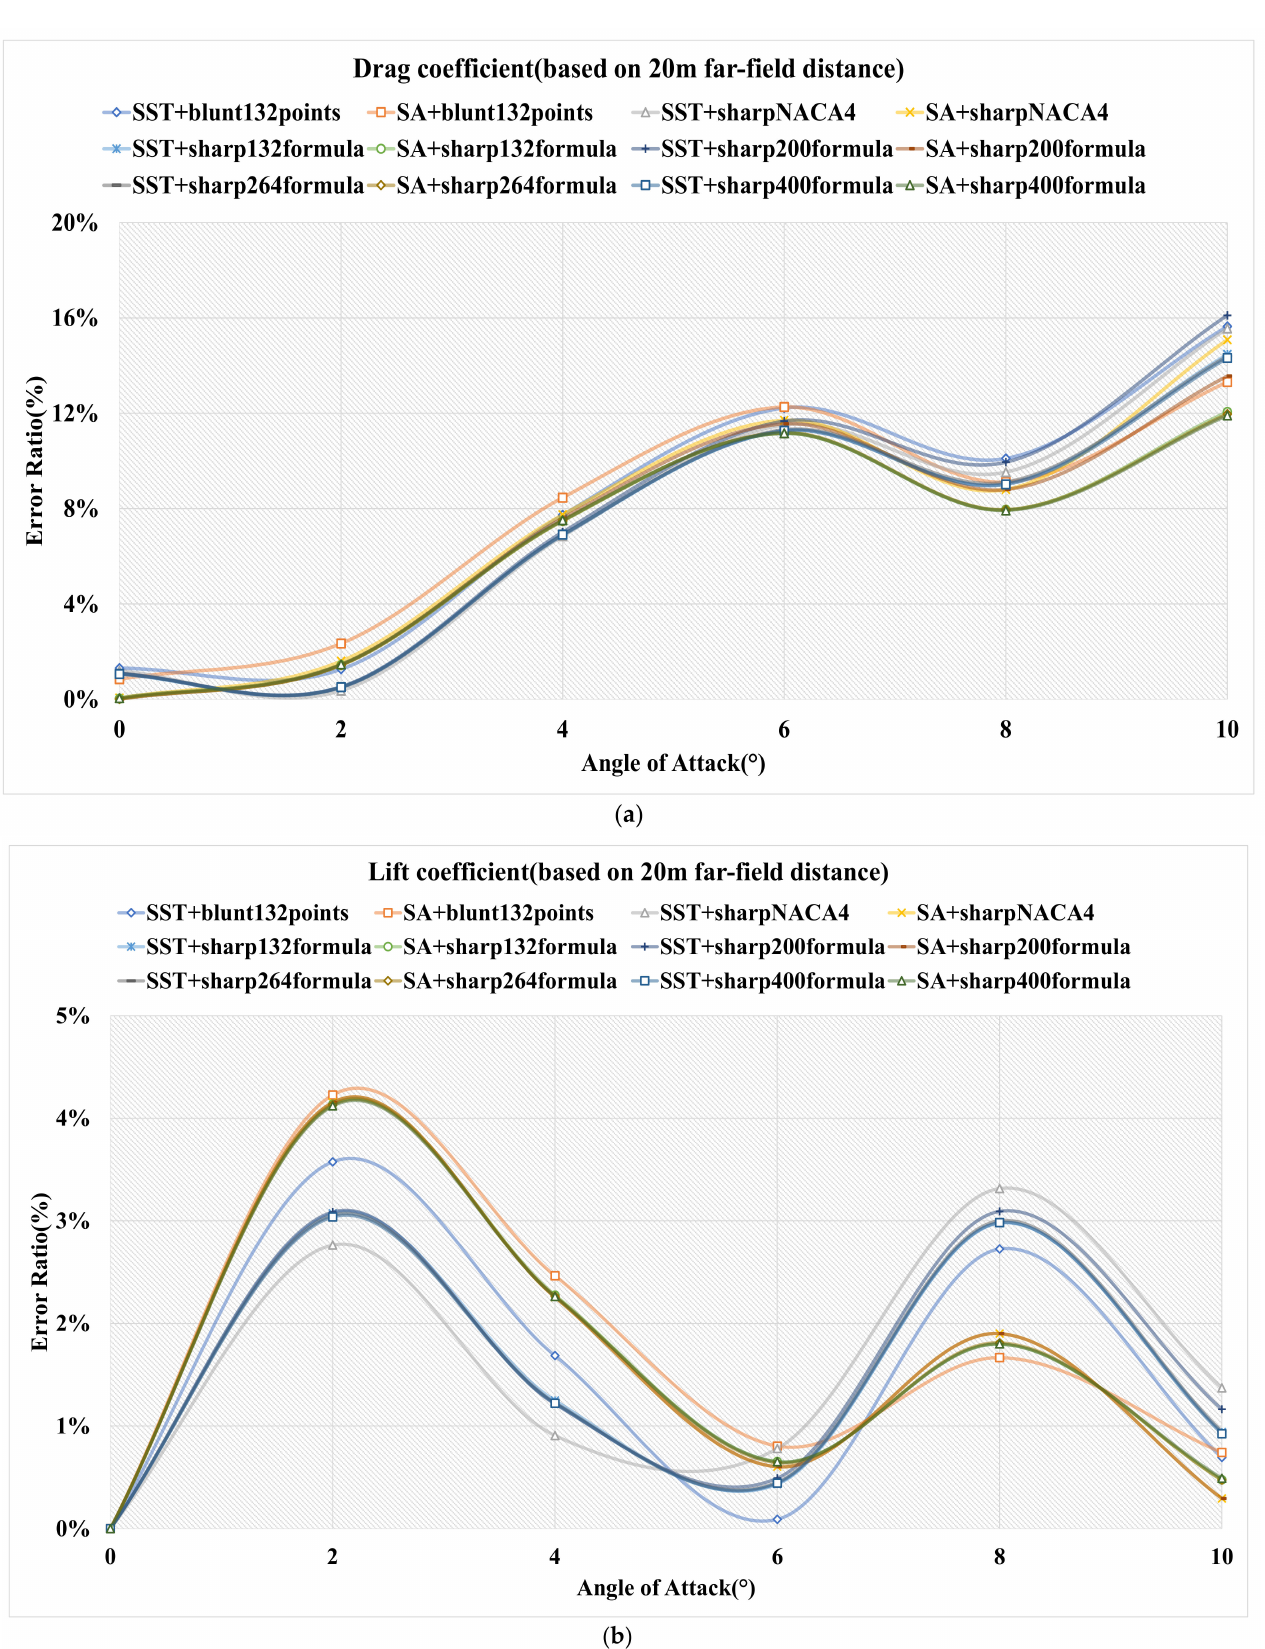
Figure 14. ( a ) Drag coefficient based on 20 m far-field distance; ( b ) lift coefficient based on 20 m far-field